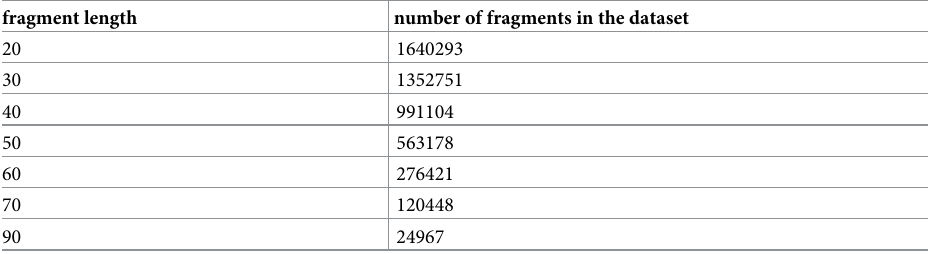
Table 1. Length dependent statistics of buried